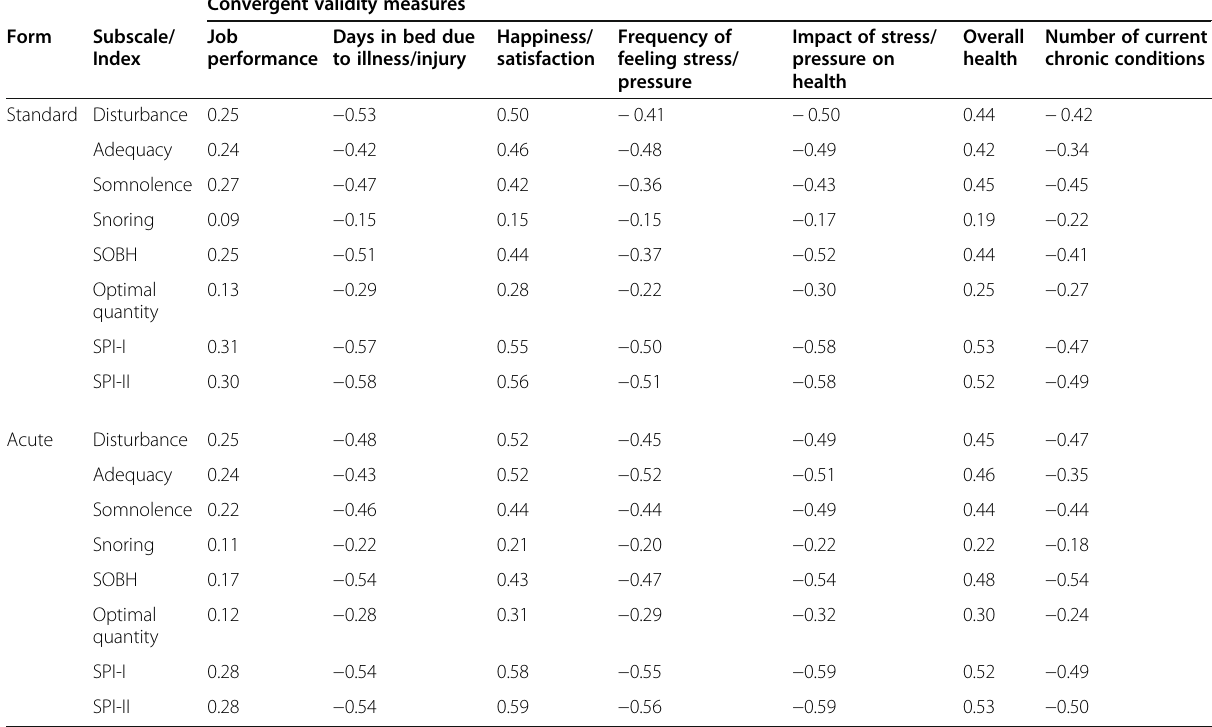
Table 7 Correlation coefficients between MOS Sleep-R scores and convergent validity measures Convergent validity measures